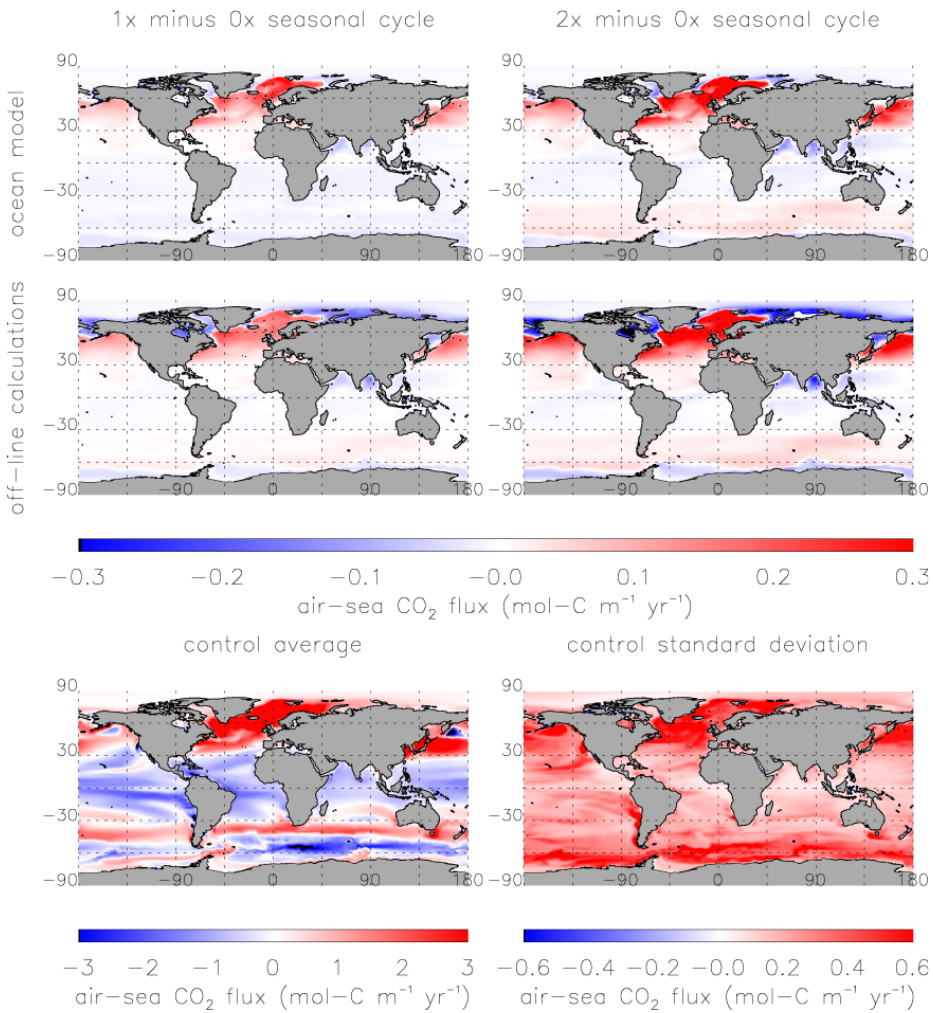
Fig. 4. Spatial maps showing the impact of changing atmospheric CO 2 seasonal cycle amplitude on the air-sea flux of CO 2 (top four figures), and the background (calculated from the first 200yr of the control simulation) annually averaged air-sea flux and standard deviation in that flux (bottom two figures). Ocean model results (top row) have been calculated over the first 12 months after the CO atm perturbation. Off-line calculations (second row from top) show an instantaneous estimate of the flux after the seasonal-cycle